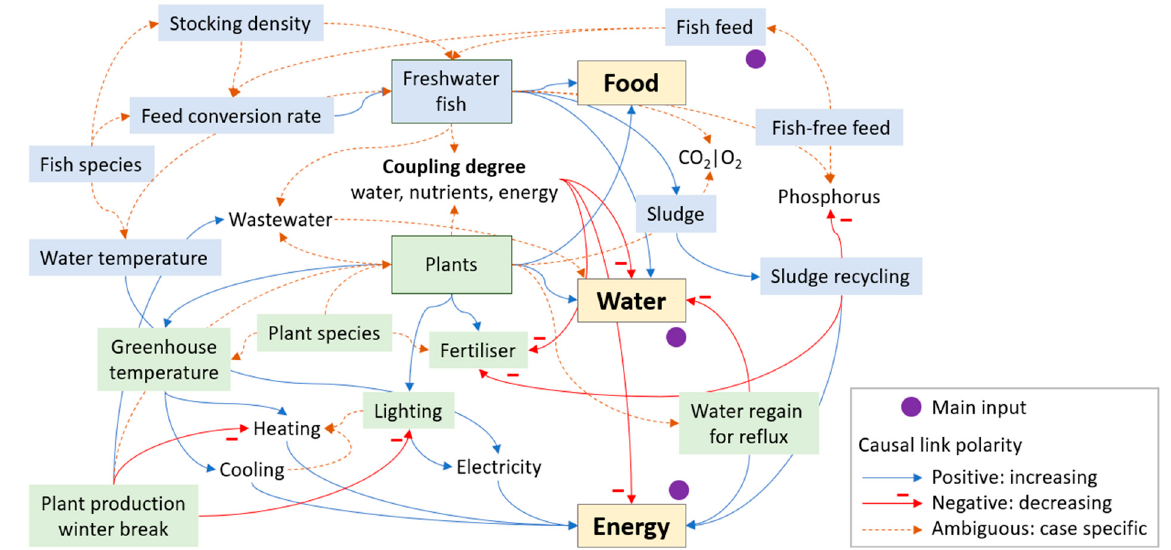
Figure 3. Impact of causal chains—formed by significant aquaponic variables—on FWE-Nexus (no flow chart; no functional scheme of an AP); the variables are explained in Table A1.